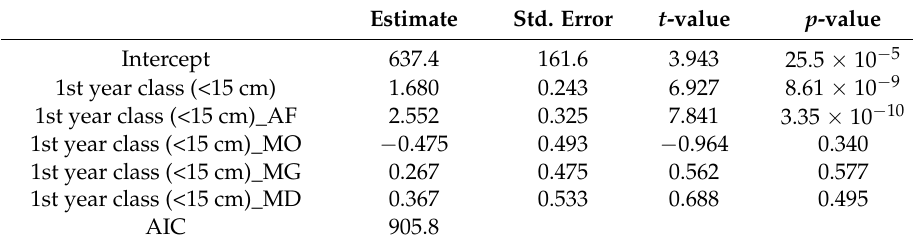
Table 2. Parameter estimates of the predictive model for the total number of removable individuals in the same cohort (first to third year individuals) as a function of the number of <15 cm individuals designated as first-year Acanthaster cf. solaris removed at each sector along the Onna Coast, Japan. AF = Afuso, MO = Minami Onna, MG = Maeganeku, MD = Maeda. p -value: significance level based on t